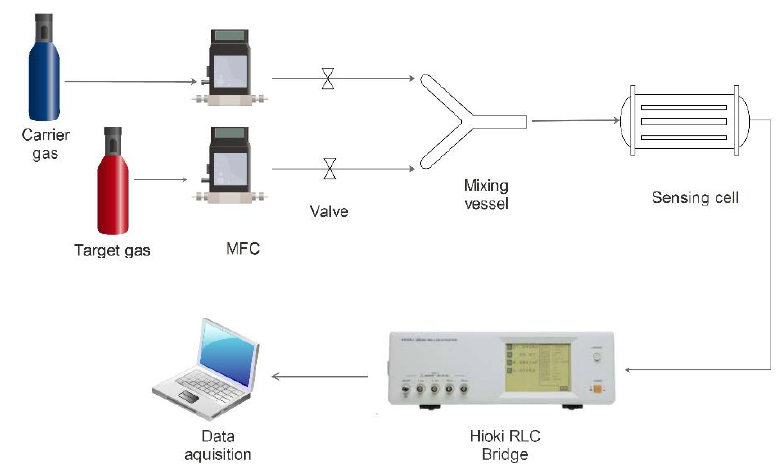
Figure 9. Schematic representation of the gas sensing experimental setup.